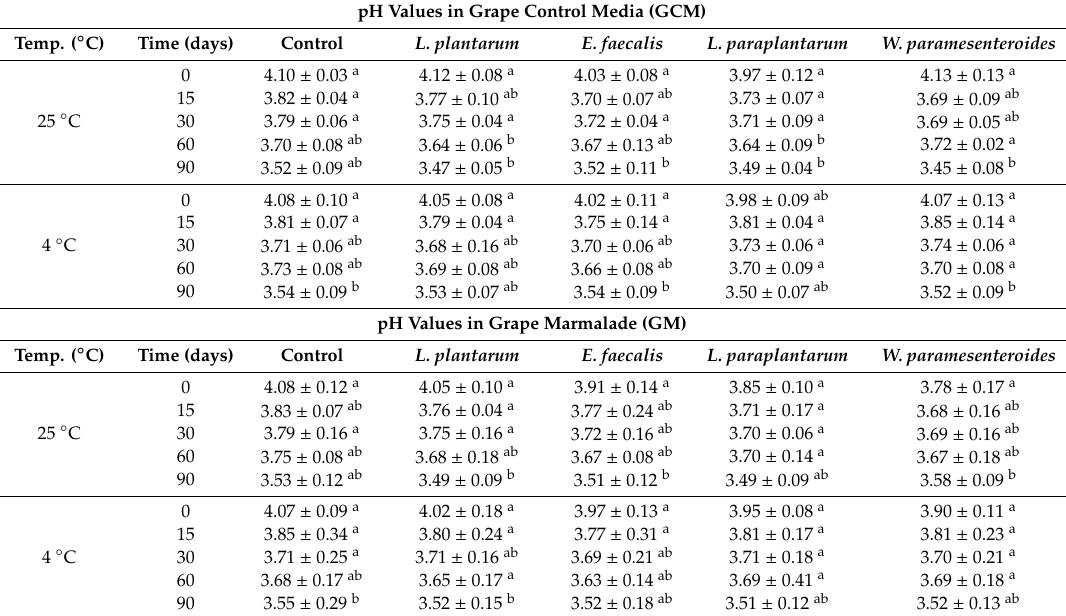
Table 2. pH values about bacteria counts for the non-inoculated and inoculated grape control media (GCM) and grape marmalade (GM) kept at room and refrigerated temperatures. pH Values in Grape Control Media (GCM) Temp. ( ◦ C)